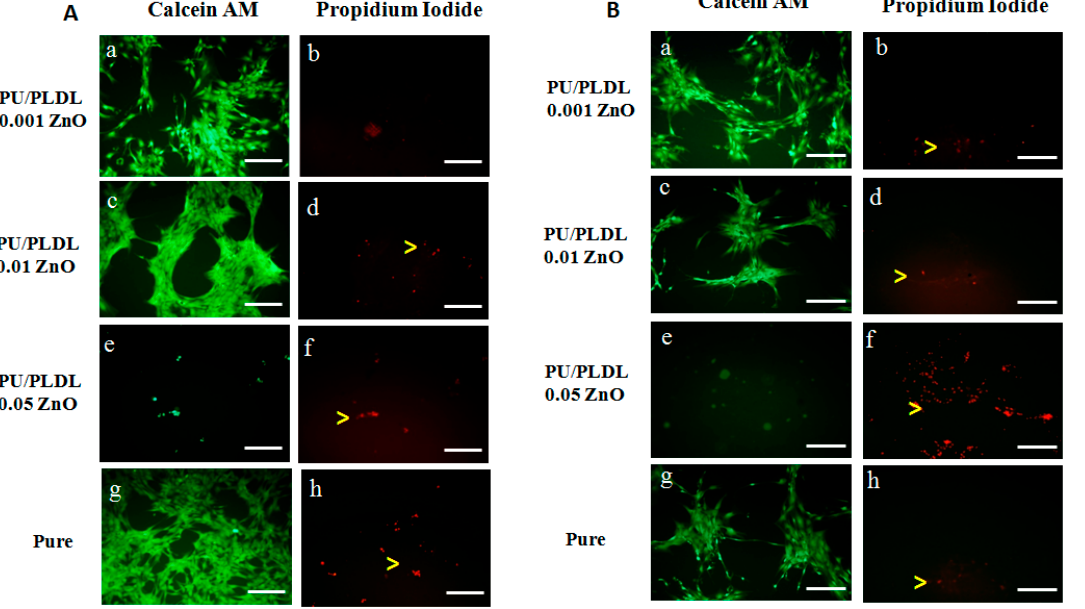
Figure 4. The calcein AM/propidium iodide staining of olfactory ensheathing cells ( A ); and adipose mesenchymal stem cells ( B ) cultured on different polymers; green—live, red—dead (yellow arrowheads); scale bar = 200 µm.